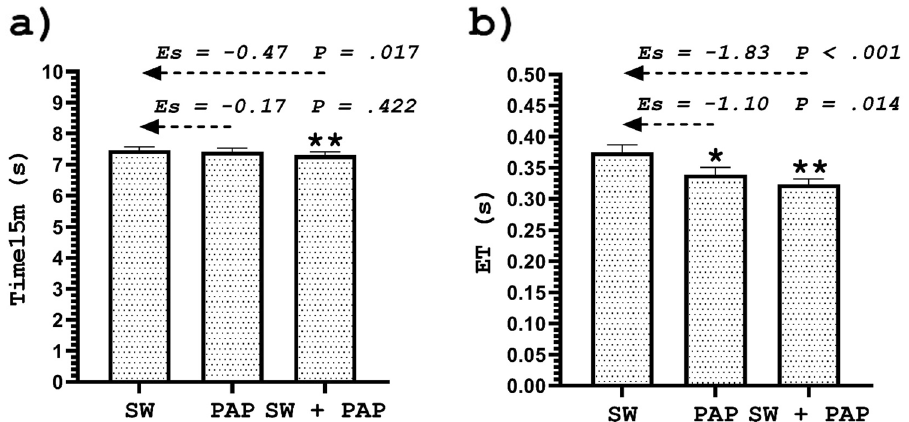
Figure 1. Swim start at 15 m ( a ) and entry time ( b ) after a swim-specific warm-up (SW), PAPE, and swim- specific warm-up with PAPE stimulus (SW + PAPE). *Indicates a significant difference between SW and PAPE. **Indicates a significant difference between SW and SW + PAPE. ES effect size. P p-value. The results are plotted as mean ±